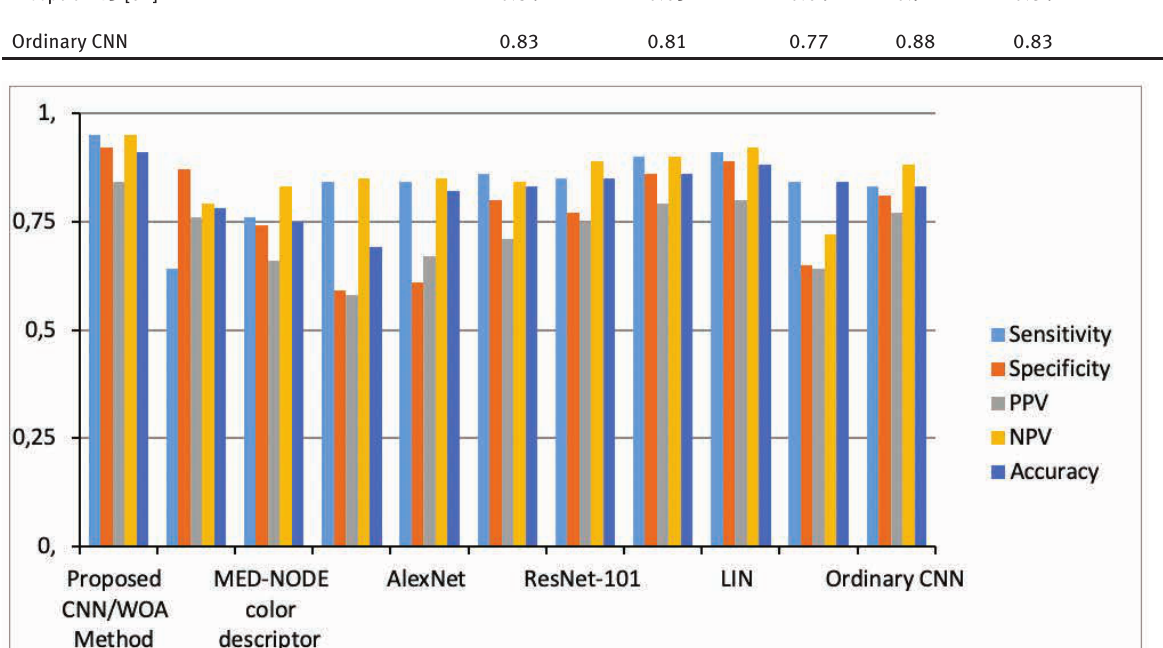
Figure 6: Distribution of classification performance of the methods for skin cancer